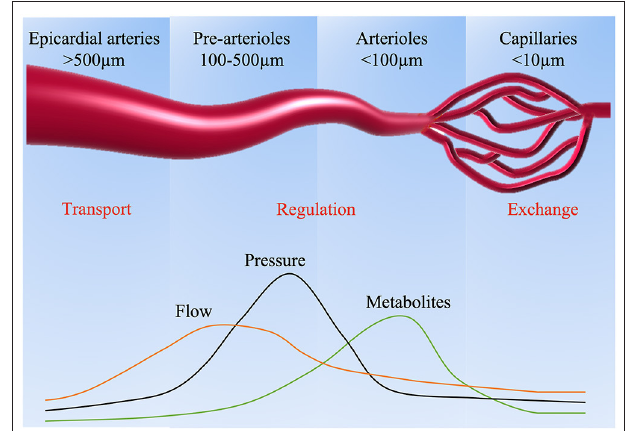
FIGURE 1 | Coronary arterial circulation and mechanisms inducing